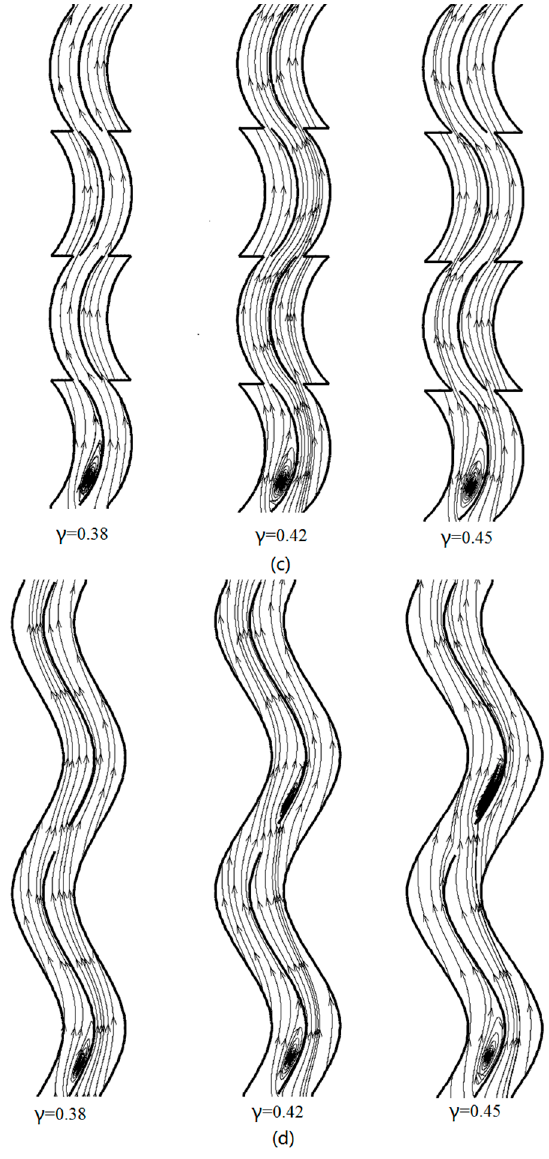
Figure 13. Change in the streamline of the ( a ) traditional wavy fin; ( b ) perforated wavy hole; ( c ) staggered wavy fin; and ( d ) discontinuous wavy fin when the waviness aspect ratio are 0.38, 0.42, and 0.45.